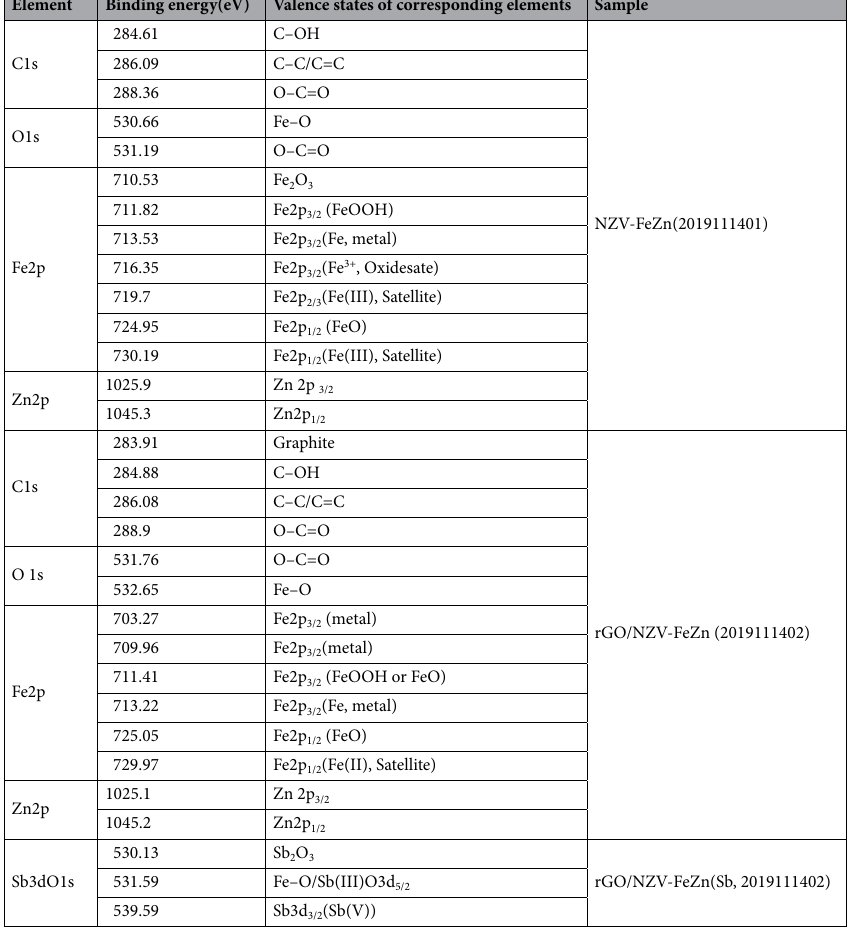
Table 2. XPS characterization test results.